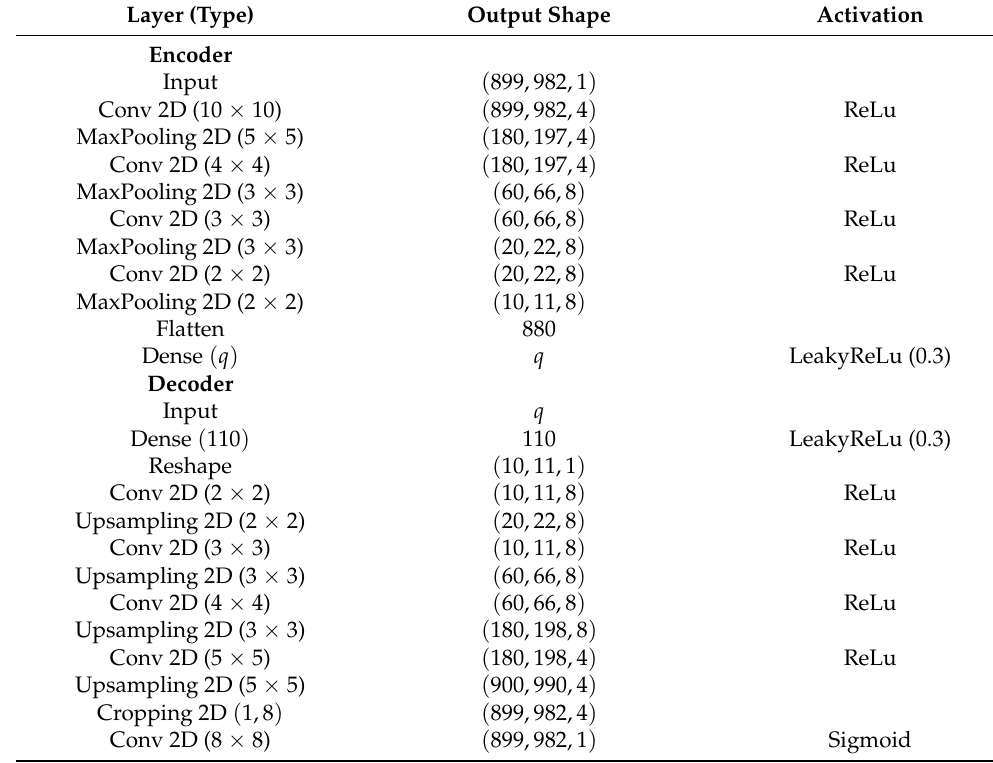
Table 3. NN structure of the CAE with ordered meshes where the latent dimension q ∈ { 10,20,30,40,50 }